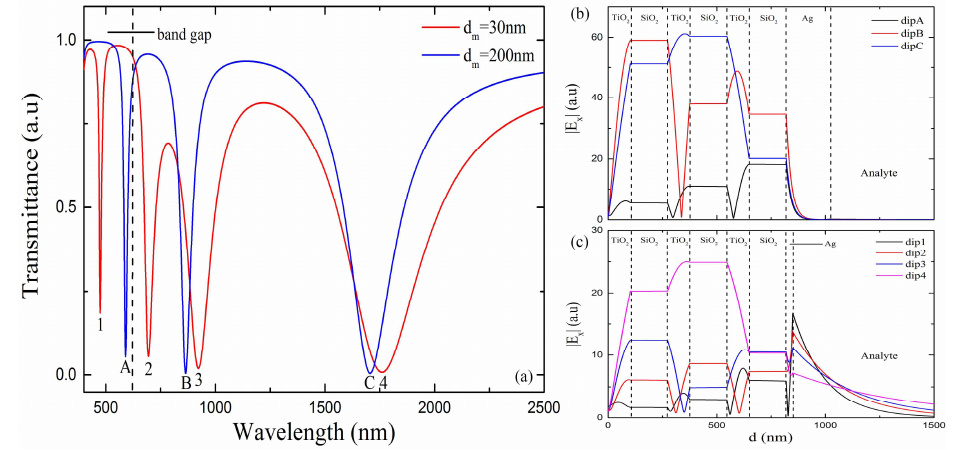
Figure 4. ( a ) Transmission spectra of the proposed sensor with different thickness of silver layer at n s = 1.37, N = 3, λ 0 = 1000 nm. ( b ) Tangential electric field distribution at the resonance wavelength 590 nm and the resonance angle of 87.25 ◦ , 864 nm and 89.54 ◦ , 1706 nm and 89.64 ◦ for dips A, B and C, respectively. The thickness of silver layer is 200 nm. ( c ) Tangential electric field distribution at 474 nm and 87.77 ◦ , 694 nm and 87.01 ◦ , 923 nm and 87.88 ◦ , 1761 nm and 89.11 ◦ for dips 1 to 4, respectively. The thickness of silver layer is 30 nm.